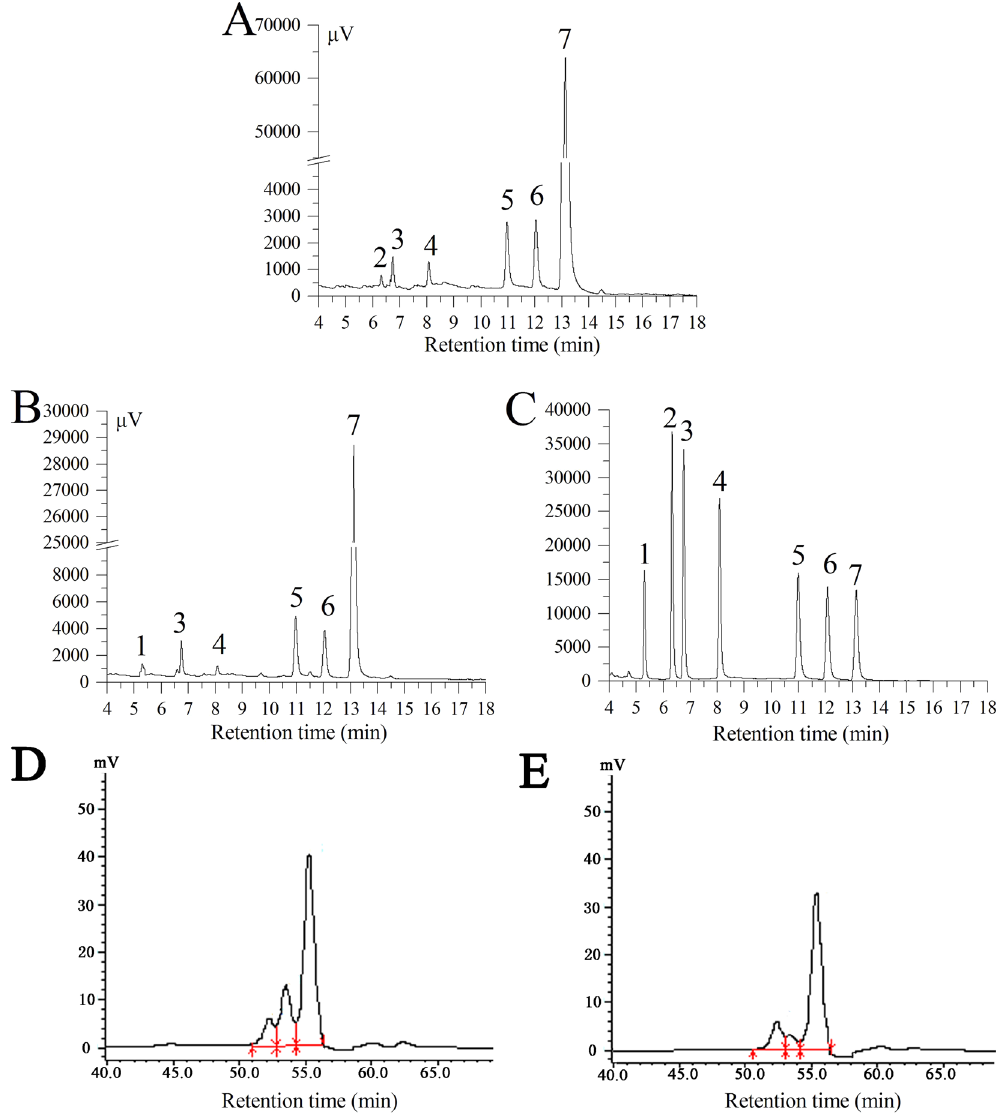
Figure 7. GC chromatograms of EPS ( A ), DEPS ( B ) and standard monosaccharides ( C ) as well as HPLC chromatograms of EPS ( D ) and DEPS ( E ) are shown. Peaks: (1) rhamnose, (2) ribose, (3) arabinose, (4) xylose, (5) mannose, (6) galactose, and (7)